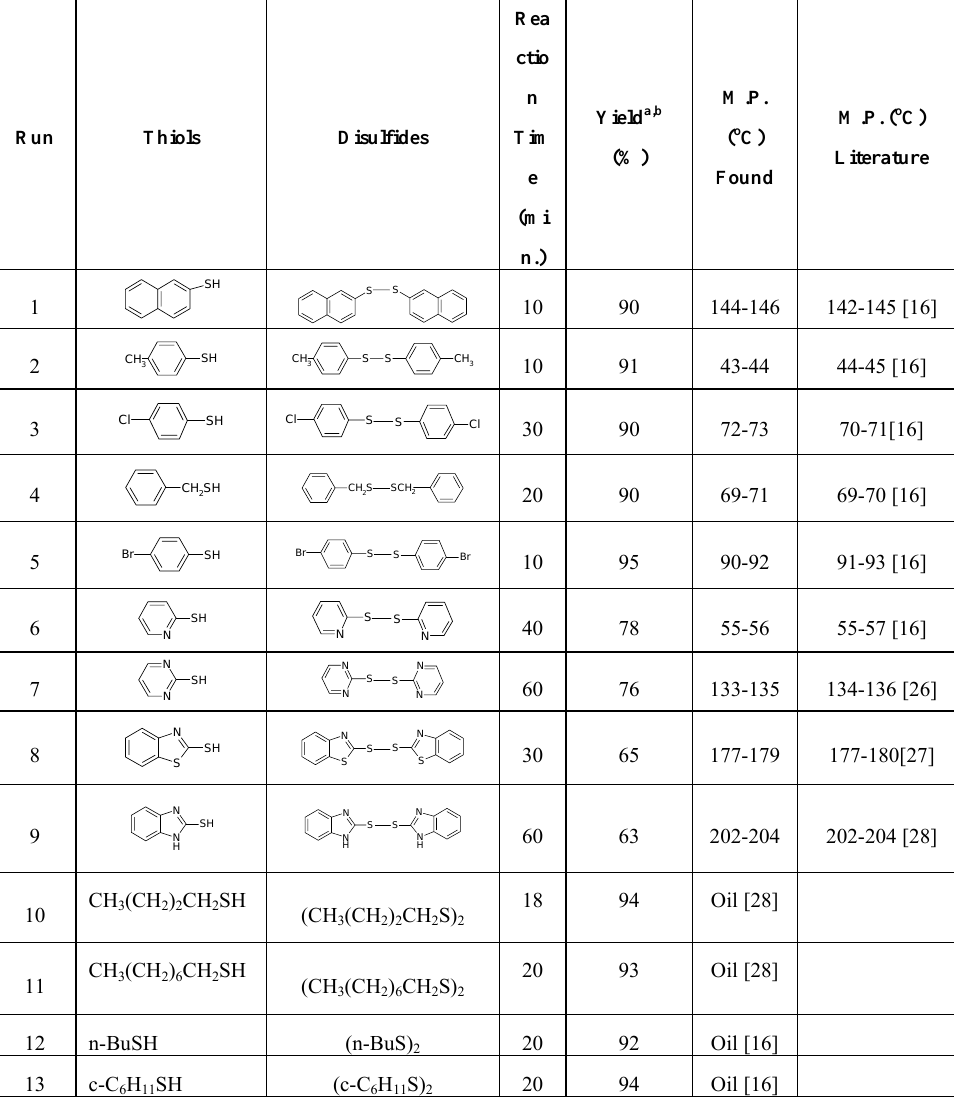
a Refers to isolated yields; b Identified by MS and 1 H-